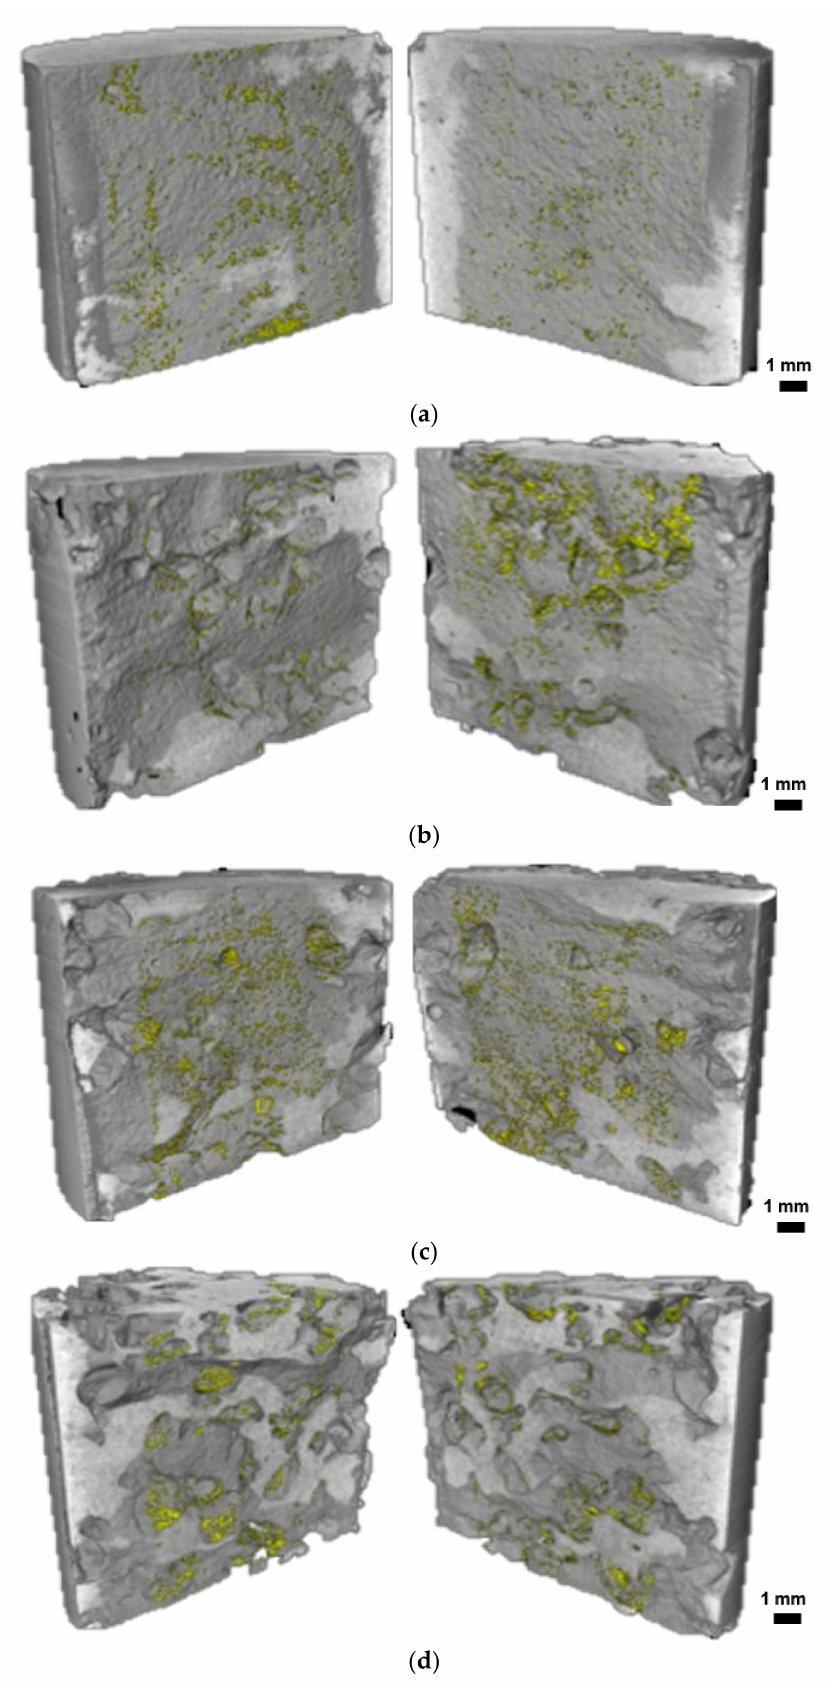
Figure 13. Three-dimensional images of split specimens; healing products are shown in yellow ( a ) REF; ( b ) S-0.5; ( c ) S-1.0; and ( d ) S-1.5